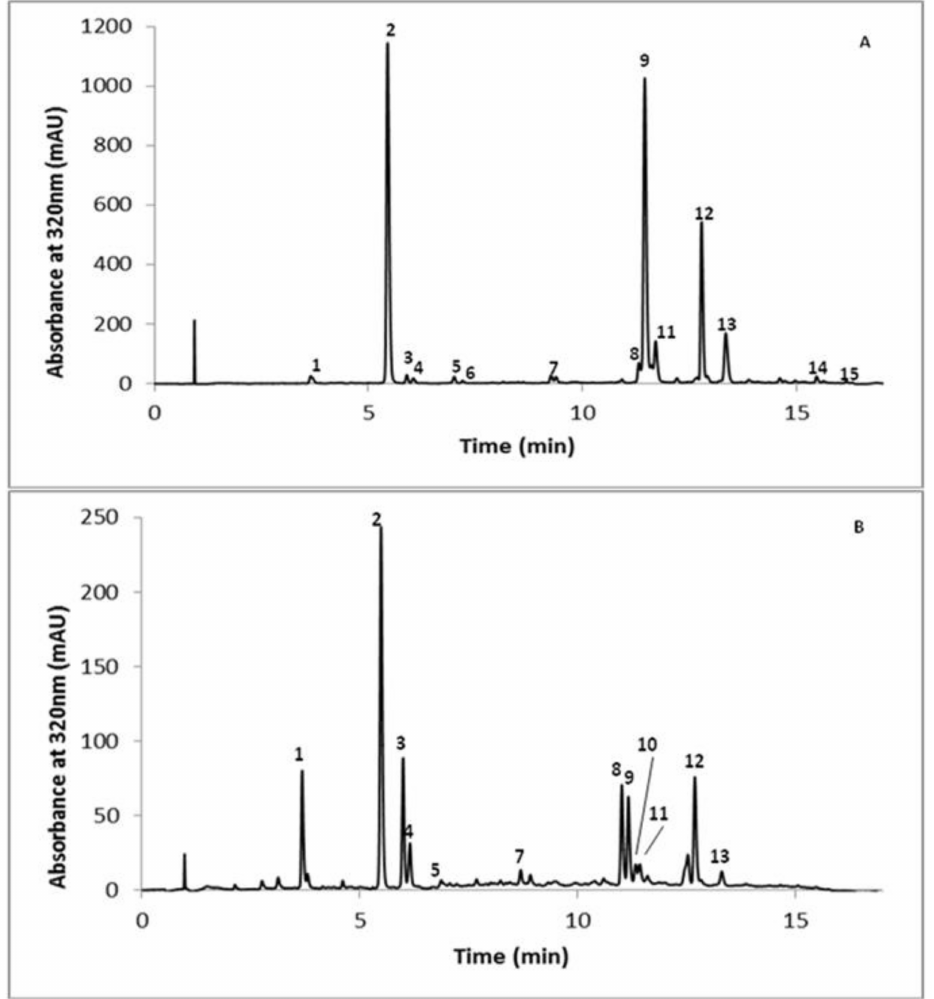
Figure 1. Chromatographic profiles of LSPSs methanolic extract ( A ) and LSPSs aqueous extracts ( B ). The chromatographic profiles are followed at 320 nm which corresponds to a wavelength where both phenolic esters and flavonoids can be detected. The numbers on the peaks are related to their identification described in Table